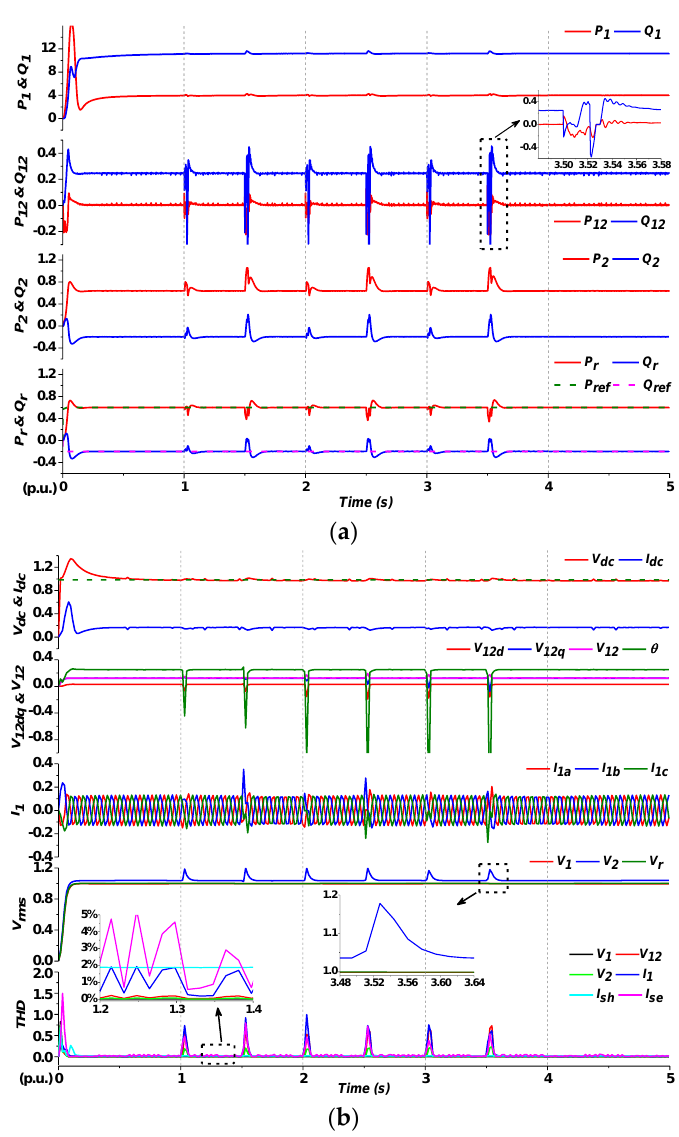
Figure 22. The simulation results of case 3. ( a ) The results of the power flow of each part; ( b ) The results of other important parameters.